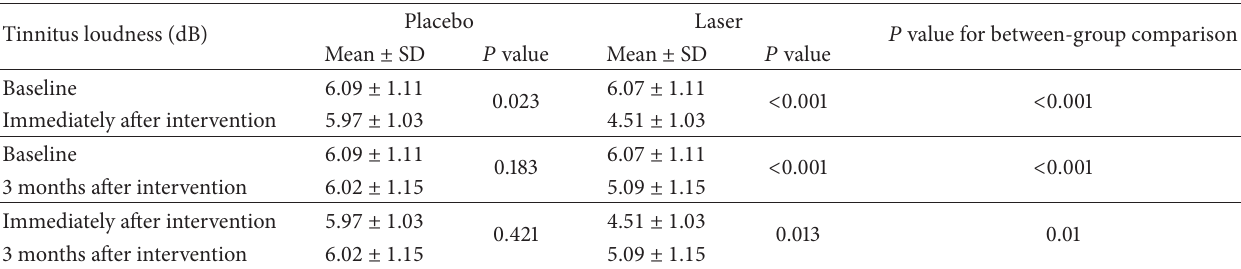
Table 3: Comparison of the changes of tinnitus loudness in 3 periods of assessment within and between groups. Tinnitus loudness